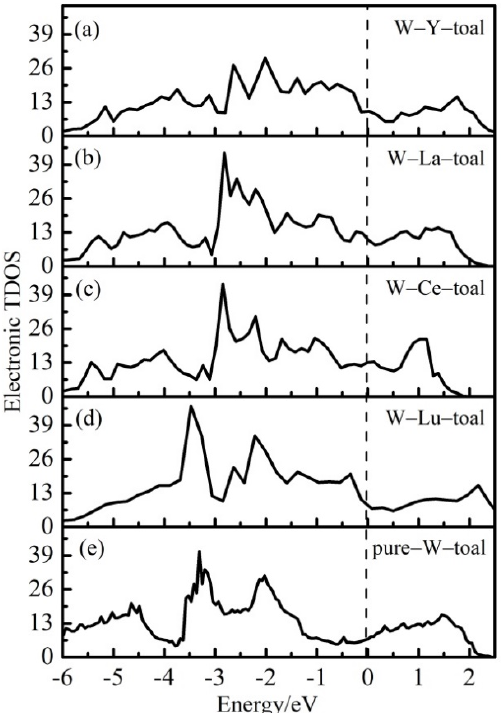
Figure 10. The total densities of states (TDOS) of bcc W 1 − x M x alloys and pure W, ( a ) W 0.875 Y 0.125 alloy, ( b ) W 0.875 La 0.125 alloy, ( c ) W 0.875 Ce 0.125 alloy, ( d ) W 0.875 Lu 0.125 alloy ( e ) and pure W.